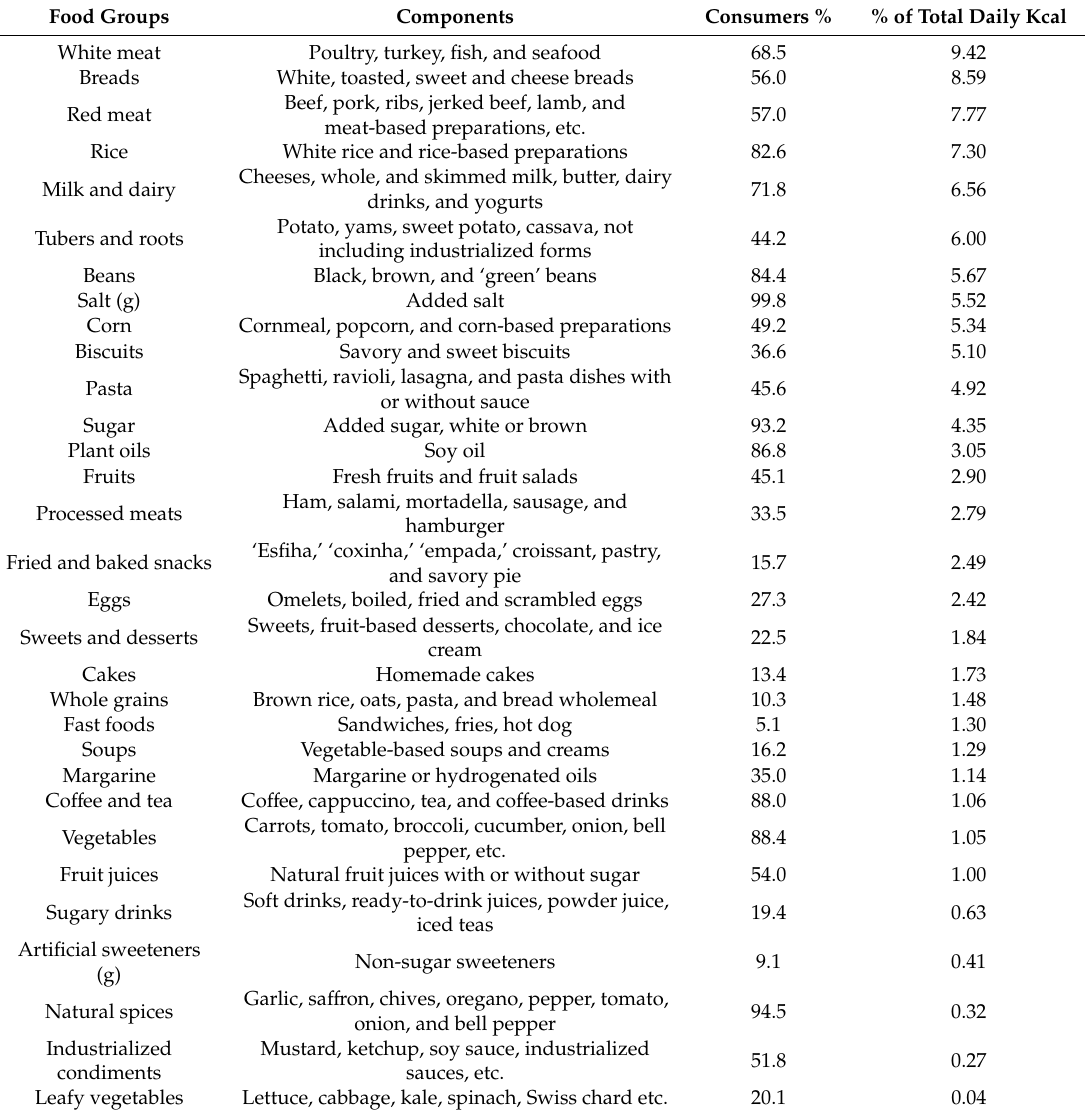
Table 3. Description of food groups and food group components consumed by 5% or more of the manufacturing workers of the State of Rio Grande do Norte, Brazil,